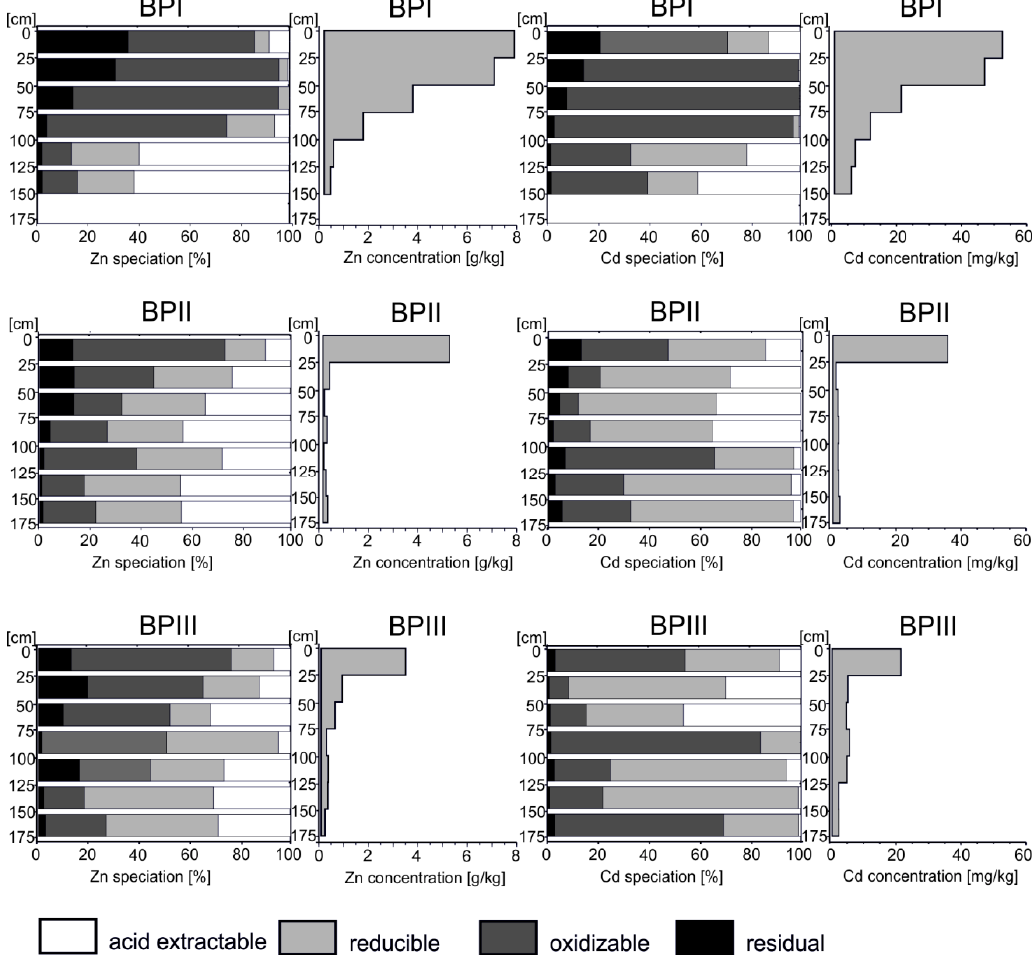
Figure 7. Zn and Cd content and speciation in the Bia ł a Przemsza River sediments.